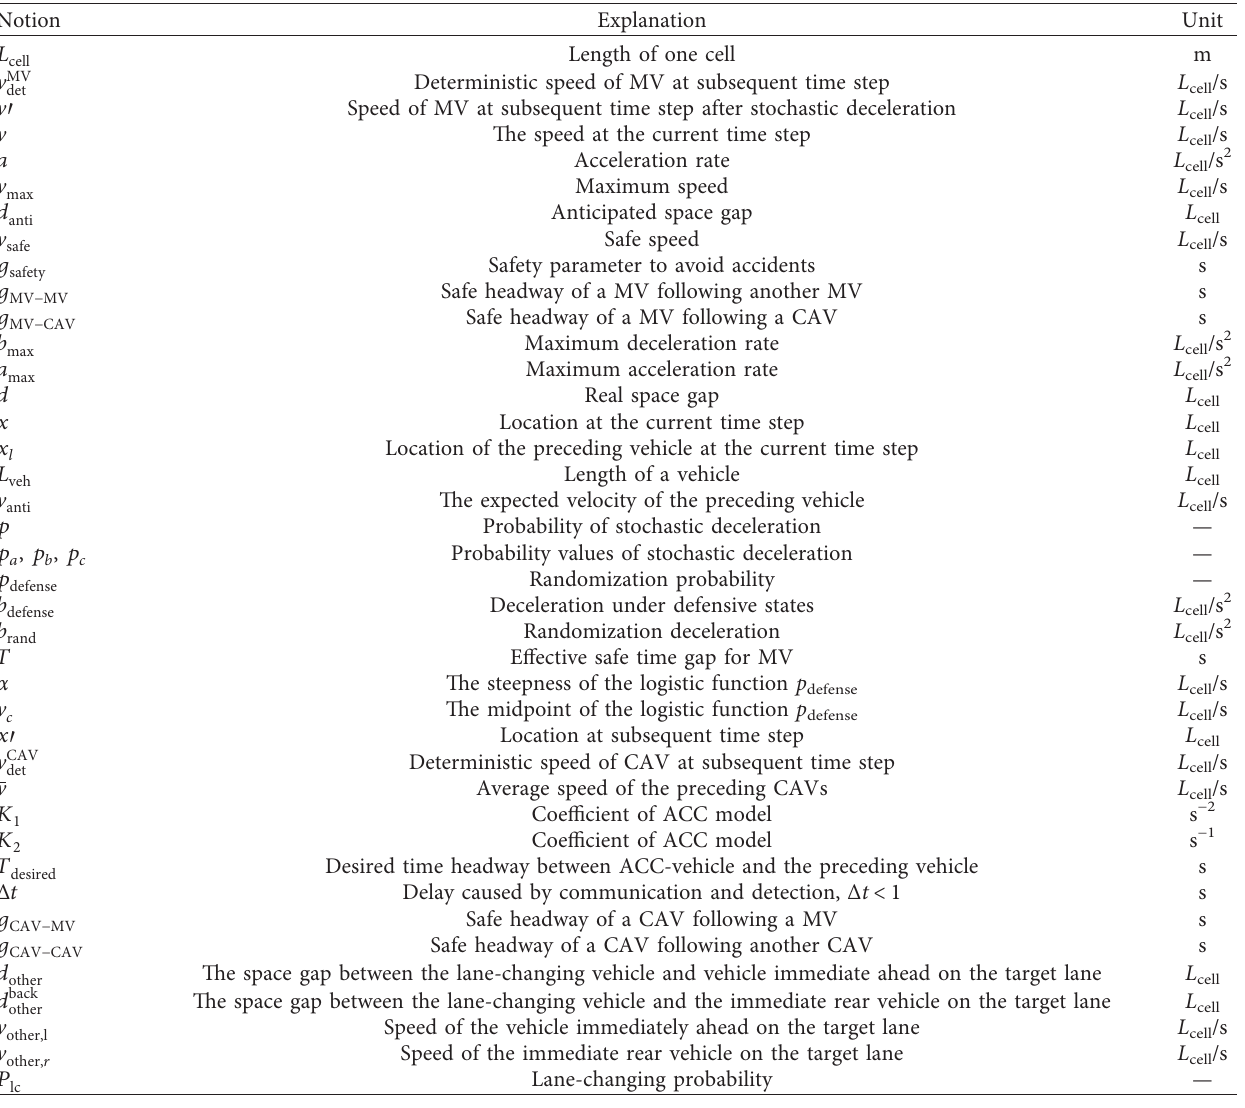
Table 1: Notation of model parameters and